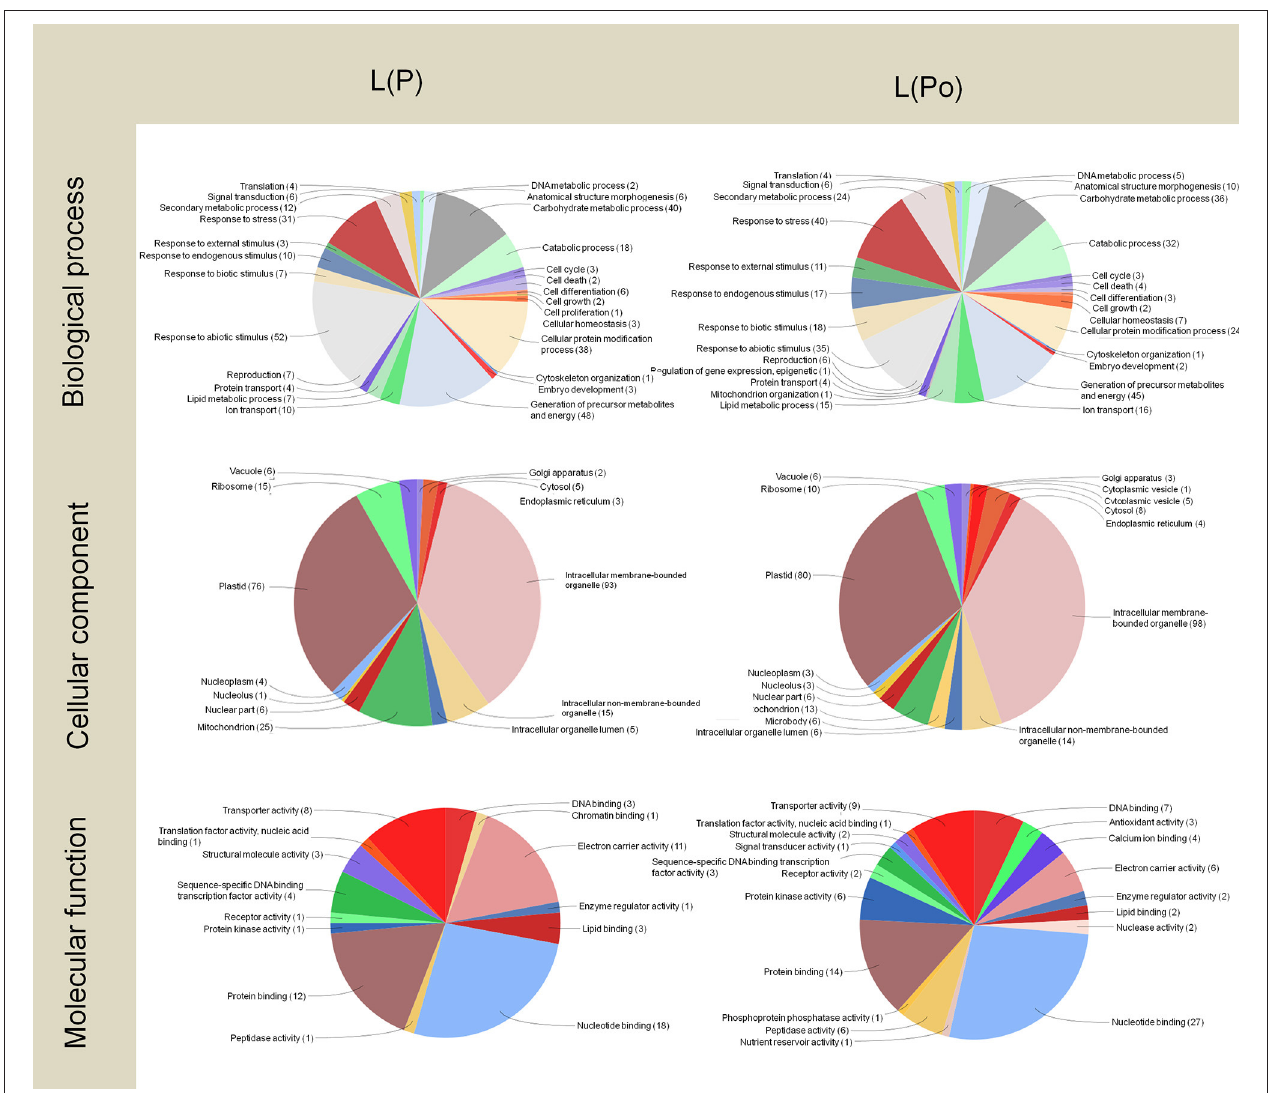
FIGURE 5 | Gene Ontology terms distribution of the L(P) and L(Po) libraries. The distribution of biological processes and molecular function was assessed to a sequence cut off = 1. The distribution of cellular components corresponds to a level = 6. The graphs were prepared using the Blast2Go